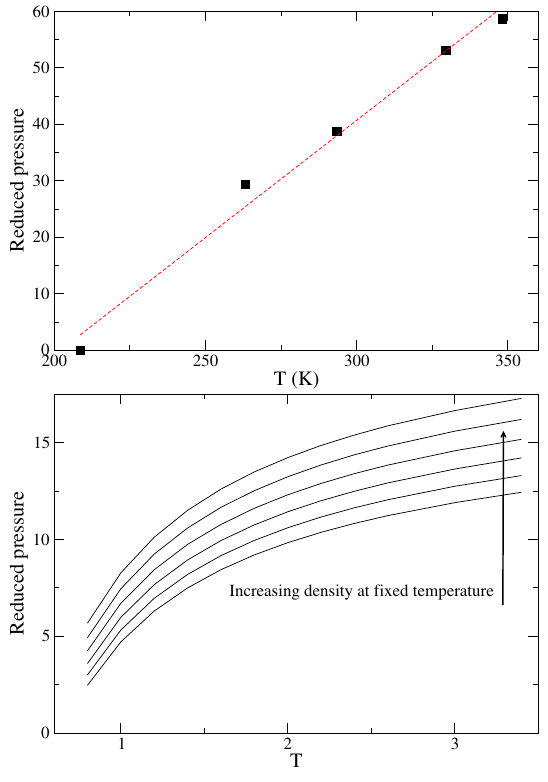
Figure 4: Left panel, reduced pressure along the τ = 0.003s isochrone for DMP. Right panel, reduced pressure along several isomorphs for the Lennard-Jones supercooled liquid. From bottom to top their densities at T = 2.0 are 1.065, 1.085, 1.105, 1.125, 1.145, 1.165. The variation of the reduced pressure along isomorphs gives information about the non-scaling part of the free energy. Note that the numerical values, although they are dimensionless, cannot